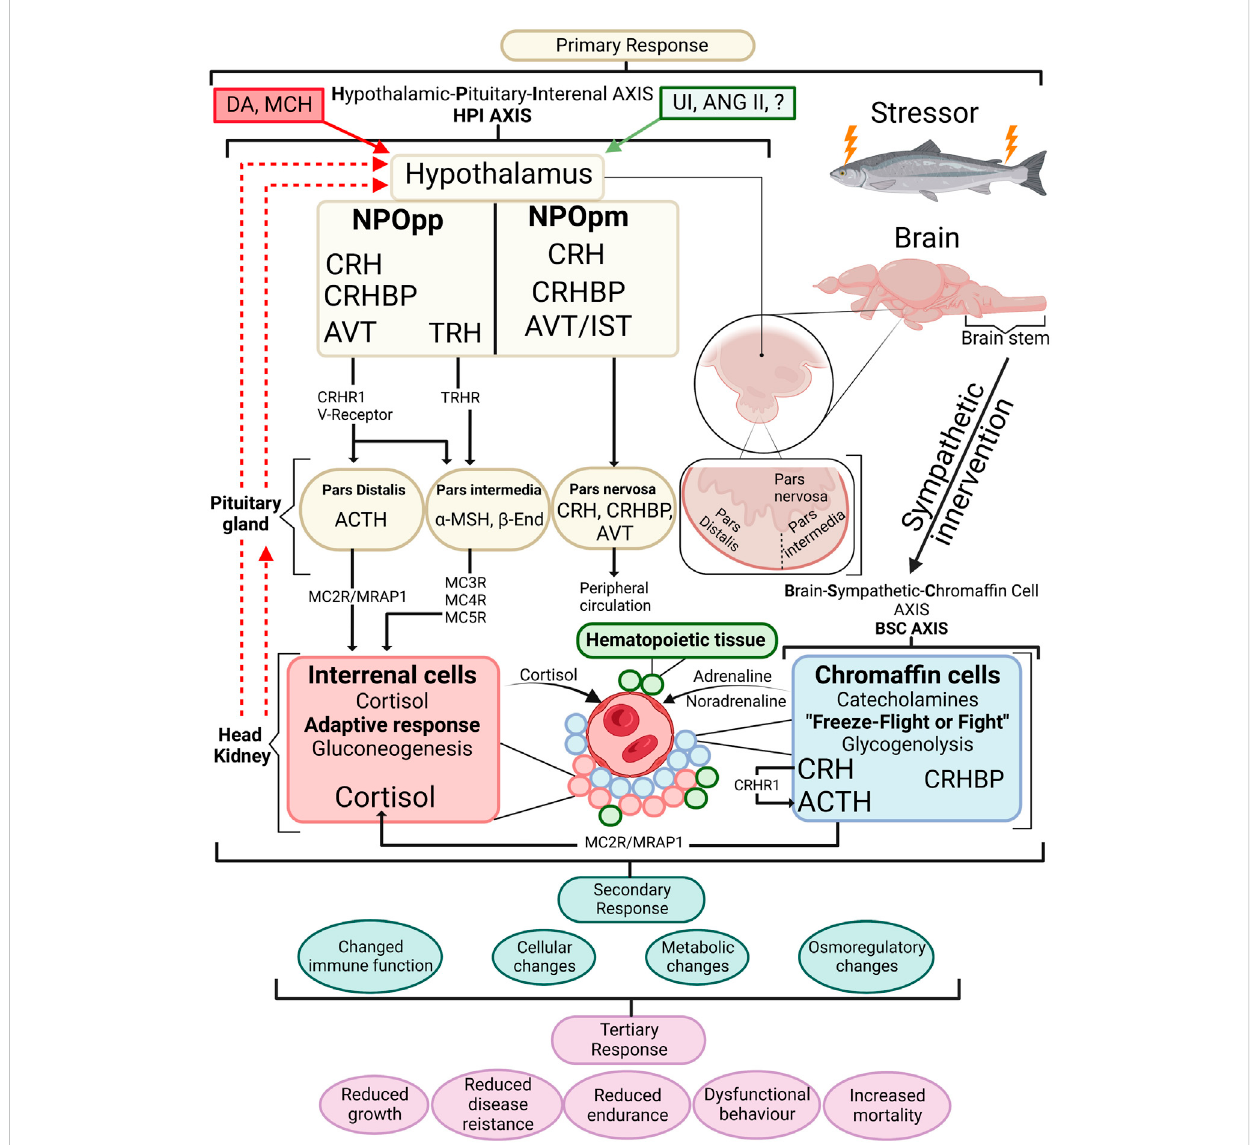
FIGURE 1 An overview of the stress response in fi sh with emphasis on the endocrine response. When a stressor is perceived, the primary stress response is activated by the BSC axis in the chromaf fi n cells of the head kidney where the initial freeze- fi ght or fl ight response releases adrenalin and noradrenalin in the circulation. Along with chromaf fi n cells the head kidney contains haematopoeitic tissue and interrenal cells. The HPI axis is activated starting within the hypothalamus where cortisol releasing hormone (CRH) containing axons are sent from the nucleus preopticus (NPOpp) to cells of adrenocorticotropic hormone (ACTH) within the pituitary. Simultaneously CRF-binding protein (CRFBP) is brought to the ACTH cells where CRF/CRFBP decides CRF bioactivity. CRF/CRFBP along with thyrotropin-releasing hormone (TRH) control the α -melanophore stimulating hormone ( α -MSH) which hasaroleinstimulatingcortisol release fromtheinterrenalcells. ACTHthroughthemelanocortin2receptor(MC2R)-melanocortin2accessoryprotein1 (MRAP1) complex induces cortisol synthesis at the interrenal. Negative feedback is visible by dashed red lines showing negative feedback on the pituitary gland and hypothalamus. Stimulatory effects (green box) produced include urocortin I (UI) angiotensin II (ANG II) as well as arginine vasotocin (AVT) and isotocin (IST) among others, and negative feedforwards (red box) include dopamine (DA) and melanin-concentrating hormone (MCH). Primary stress responses lead to secondary stress responses which are physiological adjustments to a stressor. Tertiary responses are whole-animal responses and occur after secondary responses take place. β -End (beta-endorphin). Redrawn and modi fi ed from Gorissen and Flik (2016) and Khansari et al.